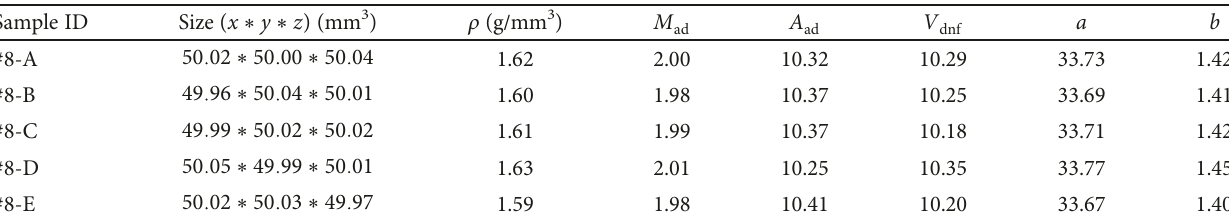
Figure 2: Schematic diagram of coal sample acquisition. Table 1: Basic parameters of coal